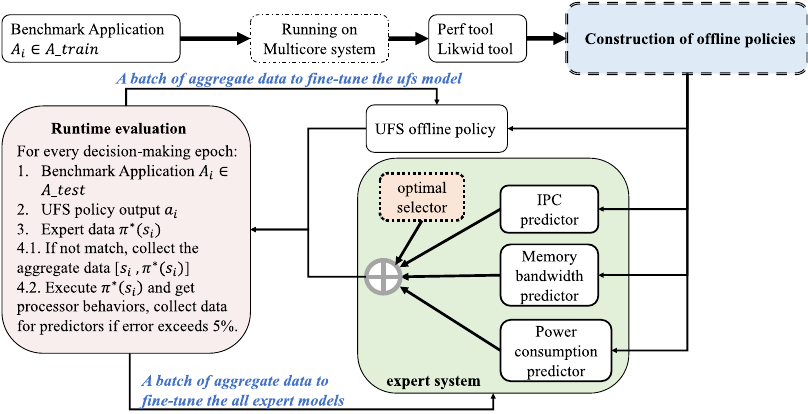
Figure 2. Imitation Learning-based UFS policy framework.